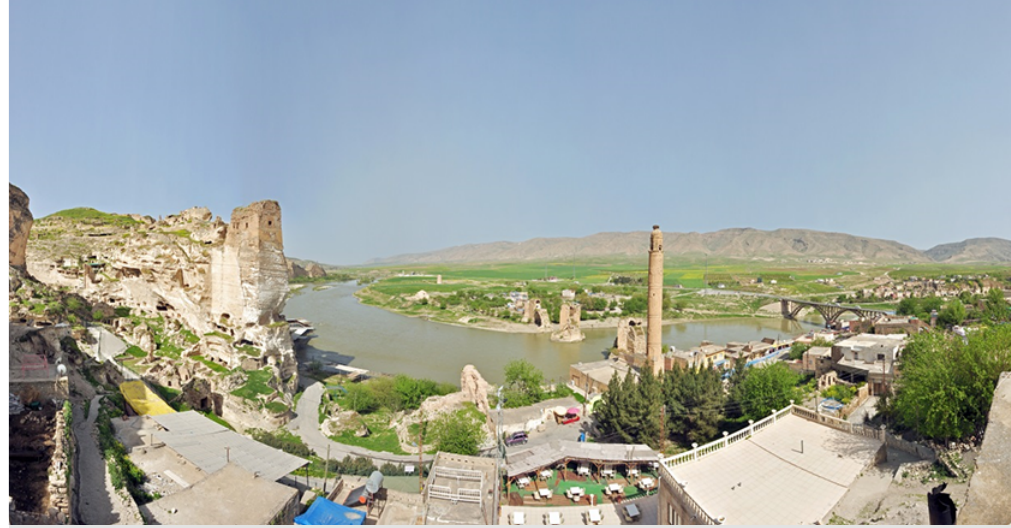
Fig. 1 Hasankeyf center, along with remains of historical construction and the cave houses,